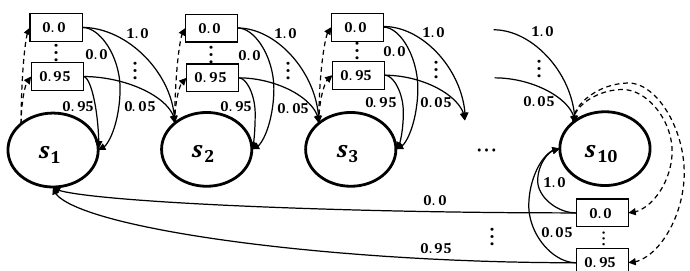
Figure 4. An extended version of the two-state